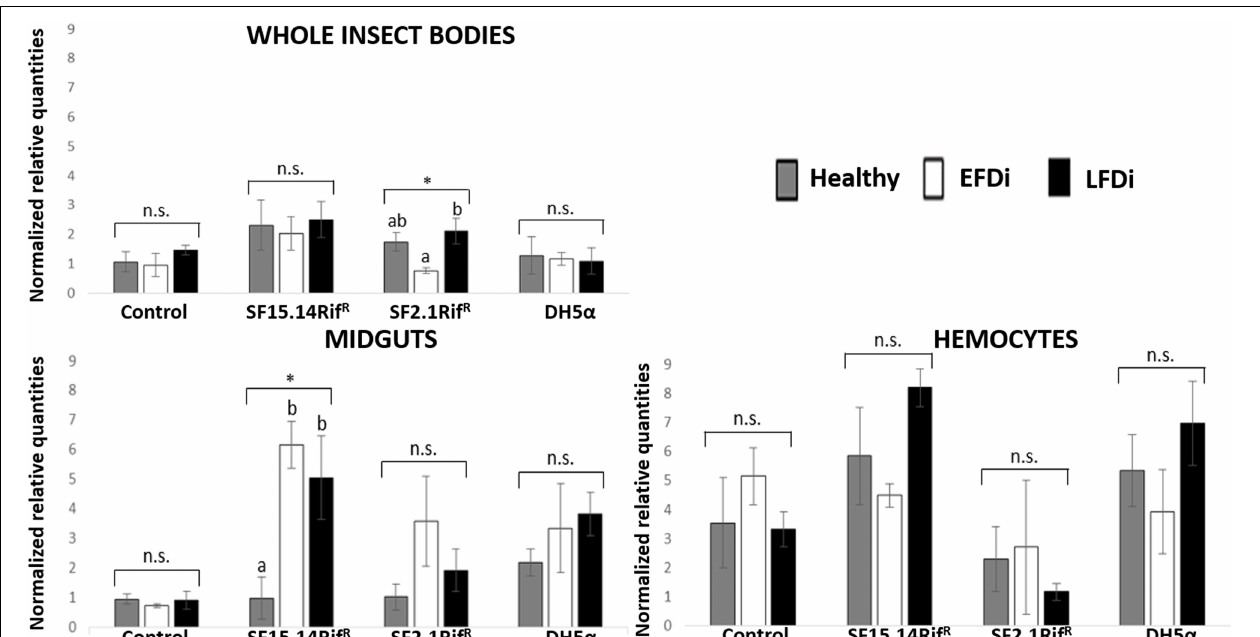
FIGURE 5 | Temporal trend of gene expression for Raf gene. Normalized relative quantities are displayed for whole insect bodies, midgut sections, and cultured hemocytes of insects treated with Asaia SF15.14Rif R , Asaia SF2.1Rif R , and E. coli DH5 α pKan(DsRed), along with the control. Healthy: time 0 of FDp infection; EFDi